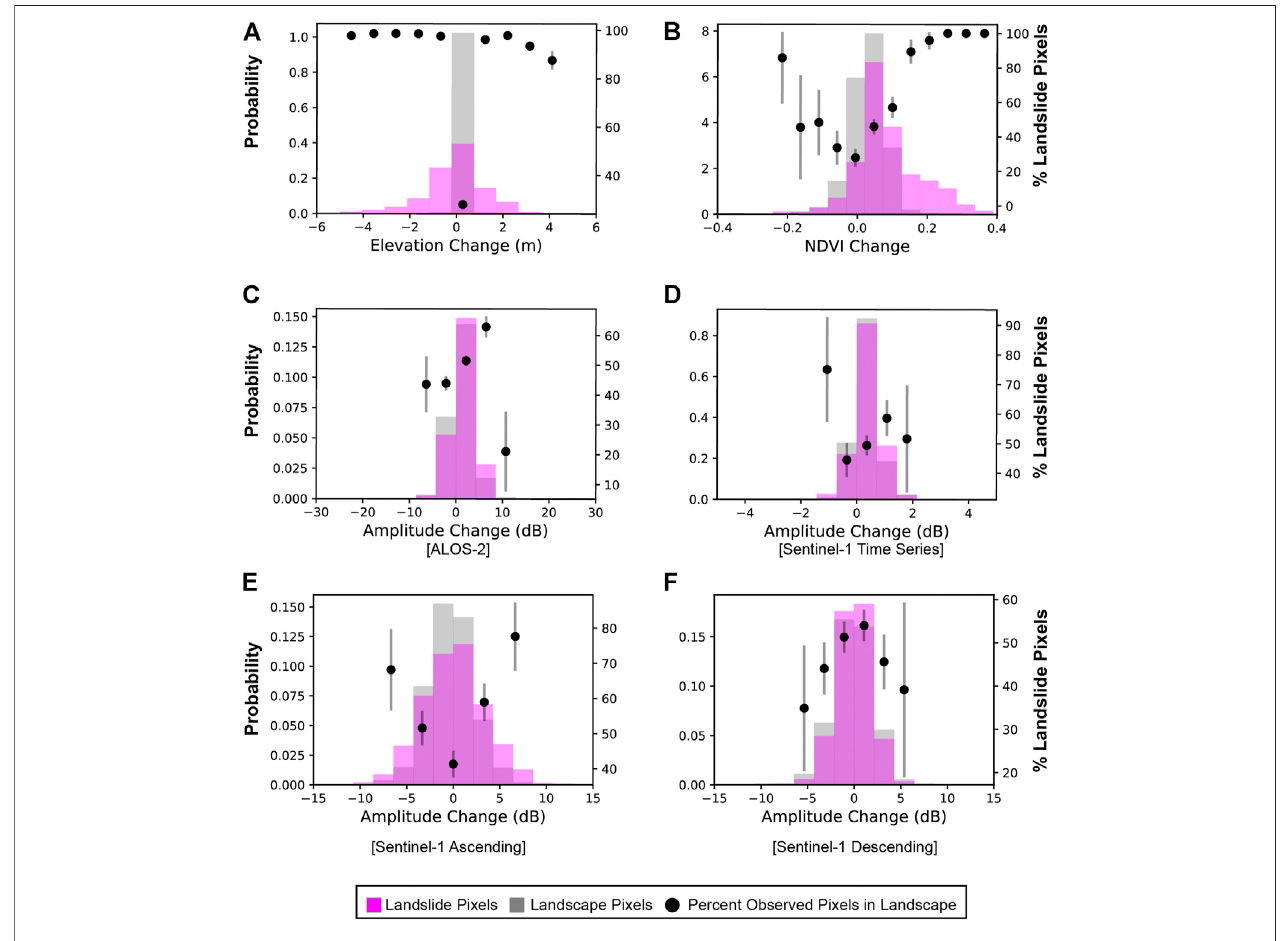
FIGURE 4 | Probability distributions comparing landslide pixels to landscape pixels for each method. Panel (A) and (B) display the distributions for the elevation and NDVI differencing,respectively.Panels (C – F) displaythedistributionsoftheremainingSARACDmethods.Con fi denceintervalforeachpointshownasgrayline(signi fi cancelevel0.05).